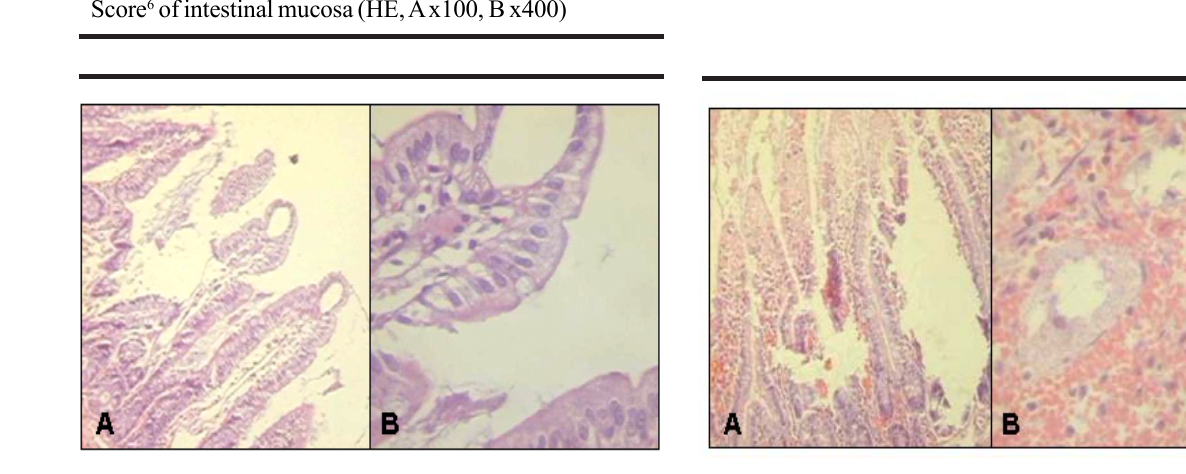
FIGURE 7 - Microphotograph of level 4 of Chiu’s Score 6 of intestinal mucosa (HE, A x100, B